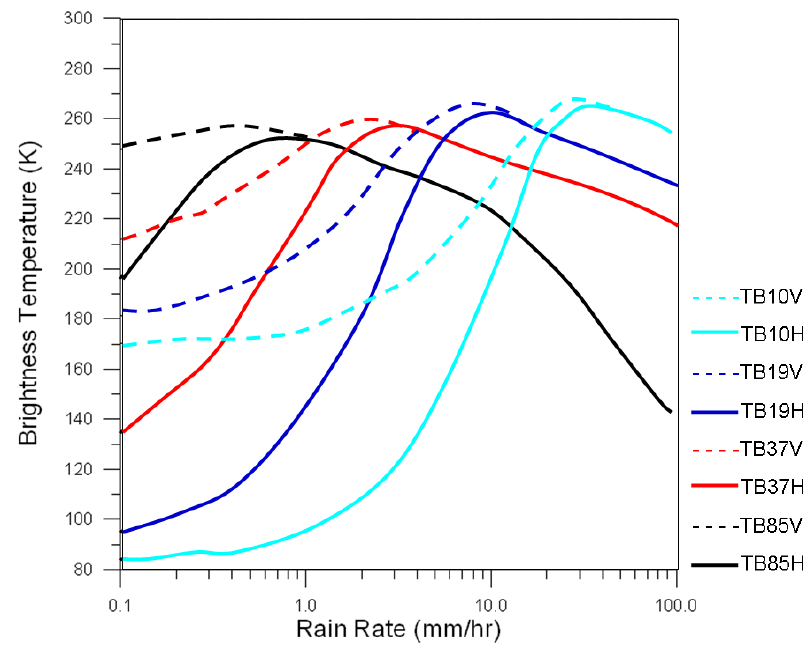
Figure 1. Ideal plot of brightness temperature (TB) versus rain rate (RR) over the ocean for the Tropical Rainfall Measuring Mission Microwave Imager (TMI) channels [35]. The text in the right side of Figure 1 describes the frequency and polarization of TMI which correspond to each